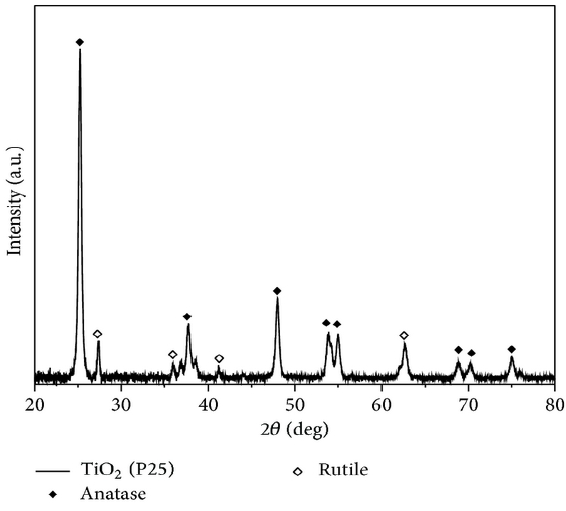
Figure 10. XRD pattern for TiO 2 P25 [49].